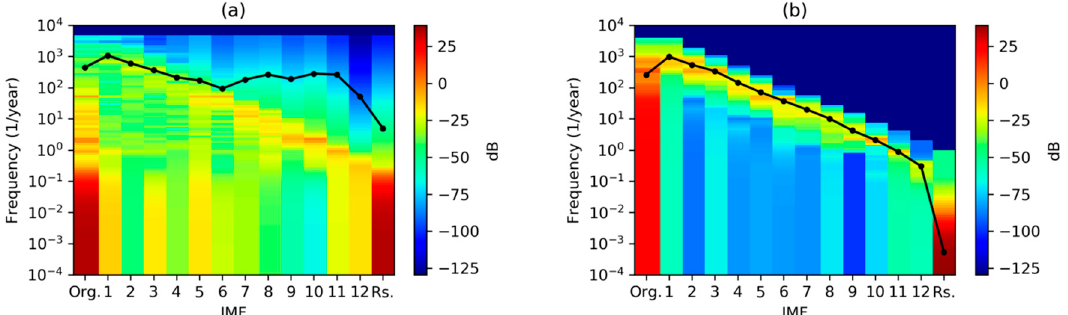
Figure 16. Spectral analysis of the electricity demand IMFs obtained using: ( a ) Discrete Fourier Transform; ( b ) Marginal Hilbert Transform. Black line shows the spectrum centroid.